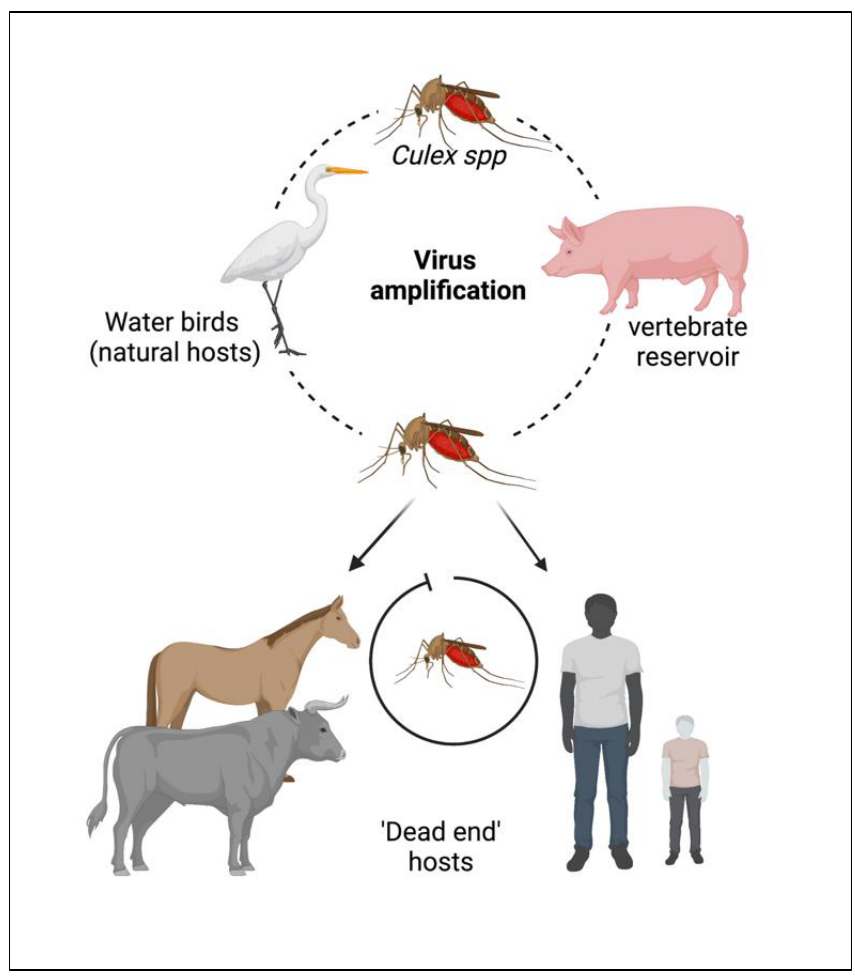
Figure 1. Cycle of the Japanese encephalitis virus (JEV) infection and amplification. Long-legged water birds, such as herons, storks, and ibises are the primary reservoirs and natural hosts for JEV. JEV-infected female mosquitoes, especially Culex tritaeniorhynchus, transmit the virus from wading water birds to other animals (pigs, cattle, and other hooved animals) and humans. Pigs act as secondary hosts where the virus becomes amplified at an optimum level and carries the infectious virion from one place to another (vector-free transmission). Female Culex mosquitos take up the virus from here and infect humans by biting them. The infected humans act as ‘dead - end’ hosts for the virus as JEV does not develop a titer high enough in the blood circulation to transmit through feeding mosquitoes.